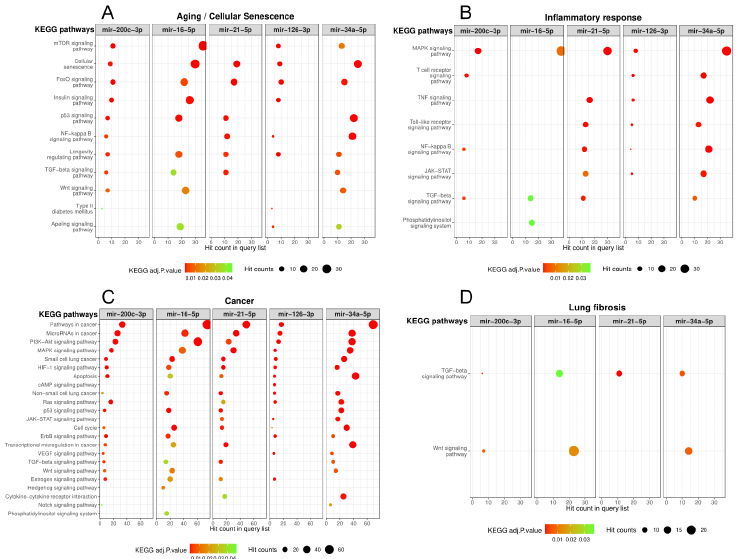
Figure 3. Significantly enriched pathways of ILA-associated miRNAs involved in ( A ) aging / cellular senescence, ( B ) inflammatory response, ( C ) cancer and ( D ) lung fibrosis. Figure shows the KEGG enriched pathways (adjusted p < 0.05) using the experimentally validated targets of ILA-associated miRNAs. Colors indicate p-values and circle sizes indicate number of target genes in each pathway. KEGG: Kyoto Encyclopedia of Genes and Genomes